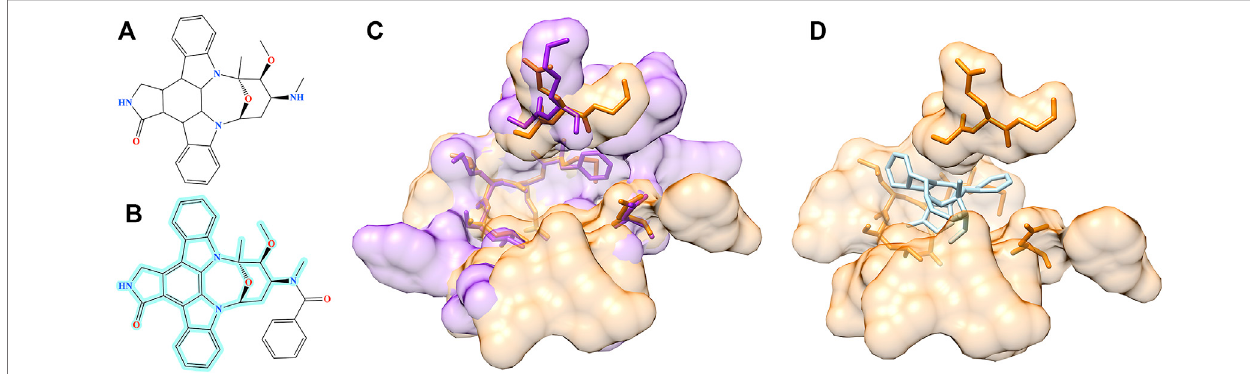
FIGURE 9 | Example of the evaluation by pocket alignment for a binding site in MSK1. (A) A molecule generated by Pocket2Drug at rank 12. (B) A similar compound, midostaurin, with the maximum common substructure to Pocket2Drug molecule highlighted in cyan. (C) A structure alignment between the target binding site in MSK1 (orange) and midostaurin binding pocket in DYRK1A (purple). (D) The molecule generated by Pocket2Drug (ice blue) docked to the target site in MSK1 (orange) with fkcombu.